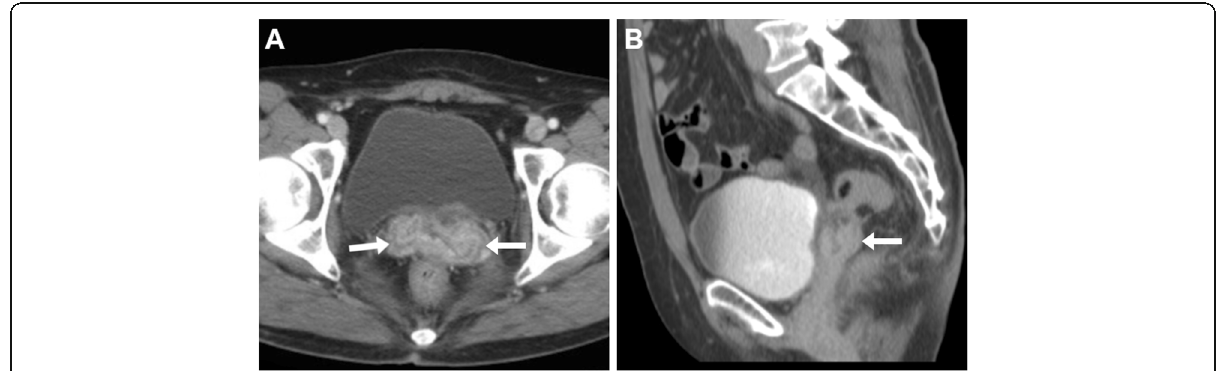
Fig. 8 Differential diagnosis of VF-related vaginitis: expected CM-enhanced CT appearance in axial ( a ) and sagittal ( b ) planes after recent vaginal hysterectomy with a “ swollen ” configuration in transverse planes, circumferential oedematous mural thickening and marked mucosal